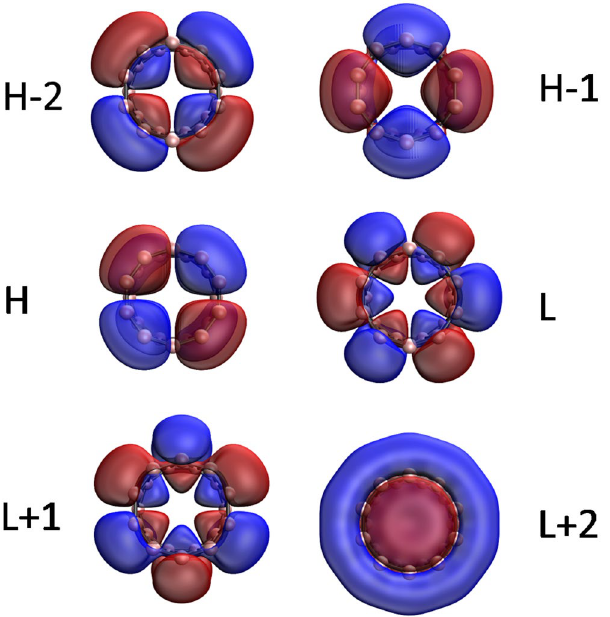
Figure 10. Visualization of the HOMO − 2 (2.000), HOMO − 1 (1.916), HOMO (1.916), LUMO (0.068), LUMO + 1 (0.068), and LUMO + 2 (0.030) for the ground state of c -BNR[2,10], obtained from spin-restricted TAO-LDA, at isovalue = 0.02 e/Å 3 . The orbital occupation numbers are shown in parentheses. Here, for simplicity, HOMO and LUMO are referred to as H and L,